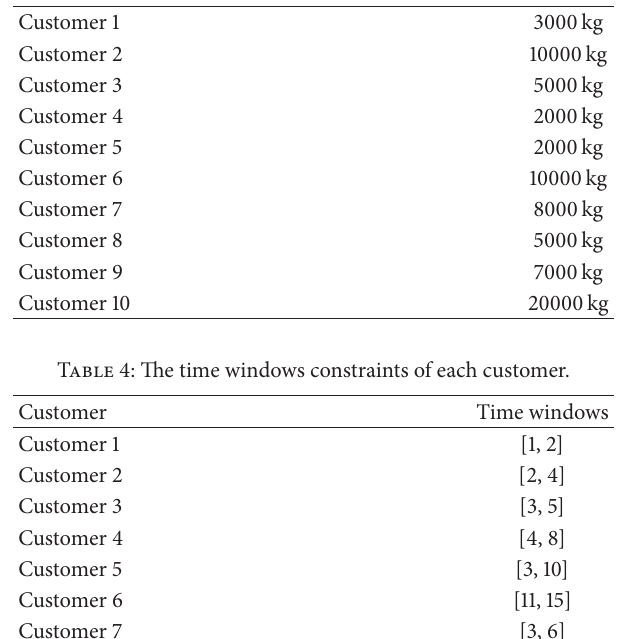
Table 3: The demand of customers.